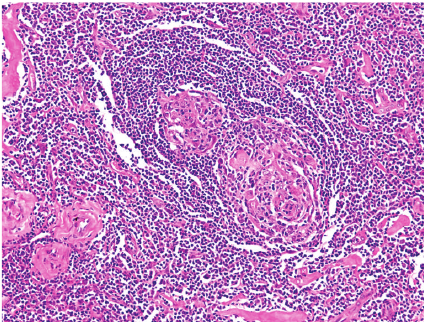
Figure 4: Two burnt-out germinal centers with vascular prolifera- tion within one follicle (10x;